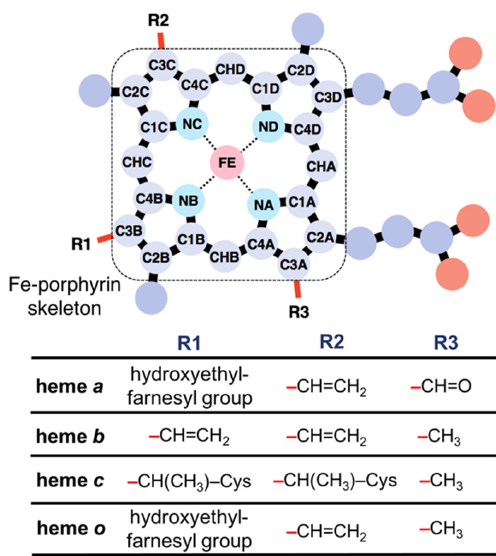
Figure 1. Chemical structures of hemes a , b , c , and o .